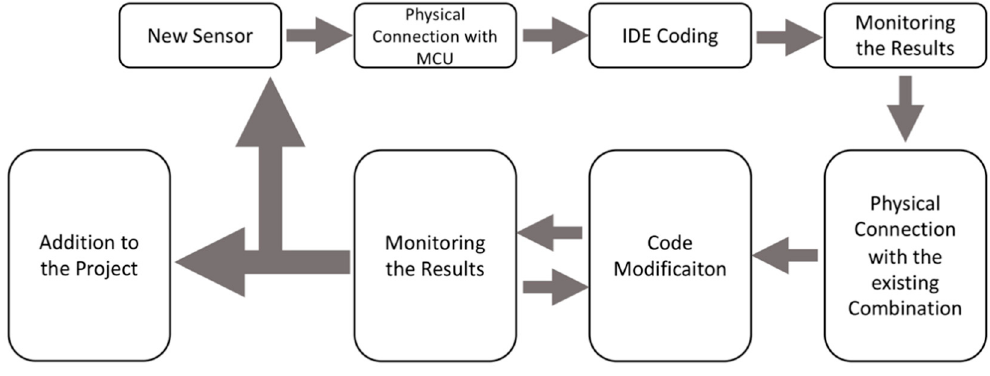
Figure 2. The process of testing environmental sensors.